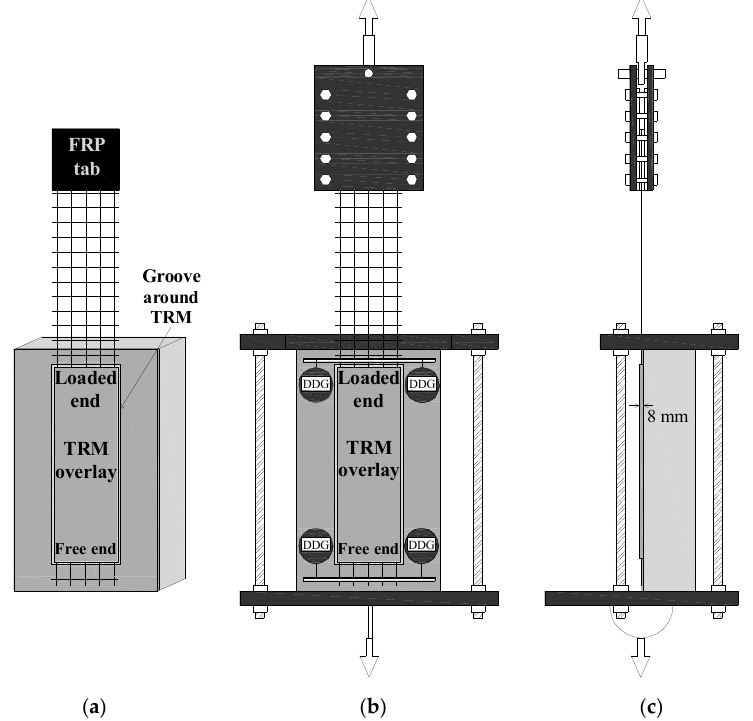
from the matrix with a displacement rate equal to 0.005 mm/s. As also depicted in Figure 5b, the instrumentation of each specimen included (i) two digital dial gauges (DDG) at- tached to the wall close to the strip’s loaded end to act against an aluminum plate glued on the first transversal yarn of the pulled textile to record the textile’s relative displace- ment in respect to the concrete prism (under the assumption of zero TRM-to-substrate slip) and (ii) two DDG glued to the wall close to the overlay’s free end to act against an textile’s slip (applied only on one specimen in a group of identical specimens).